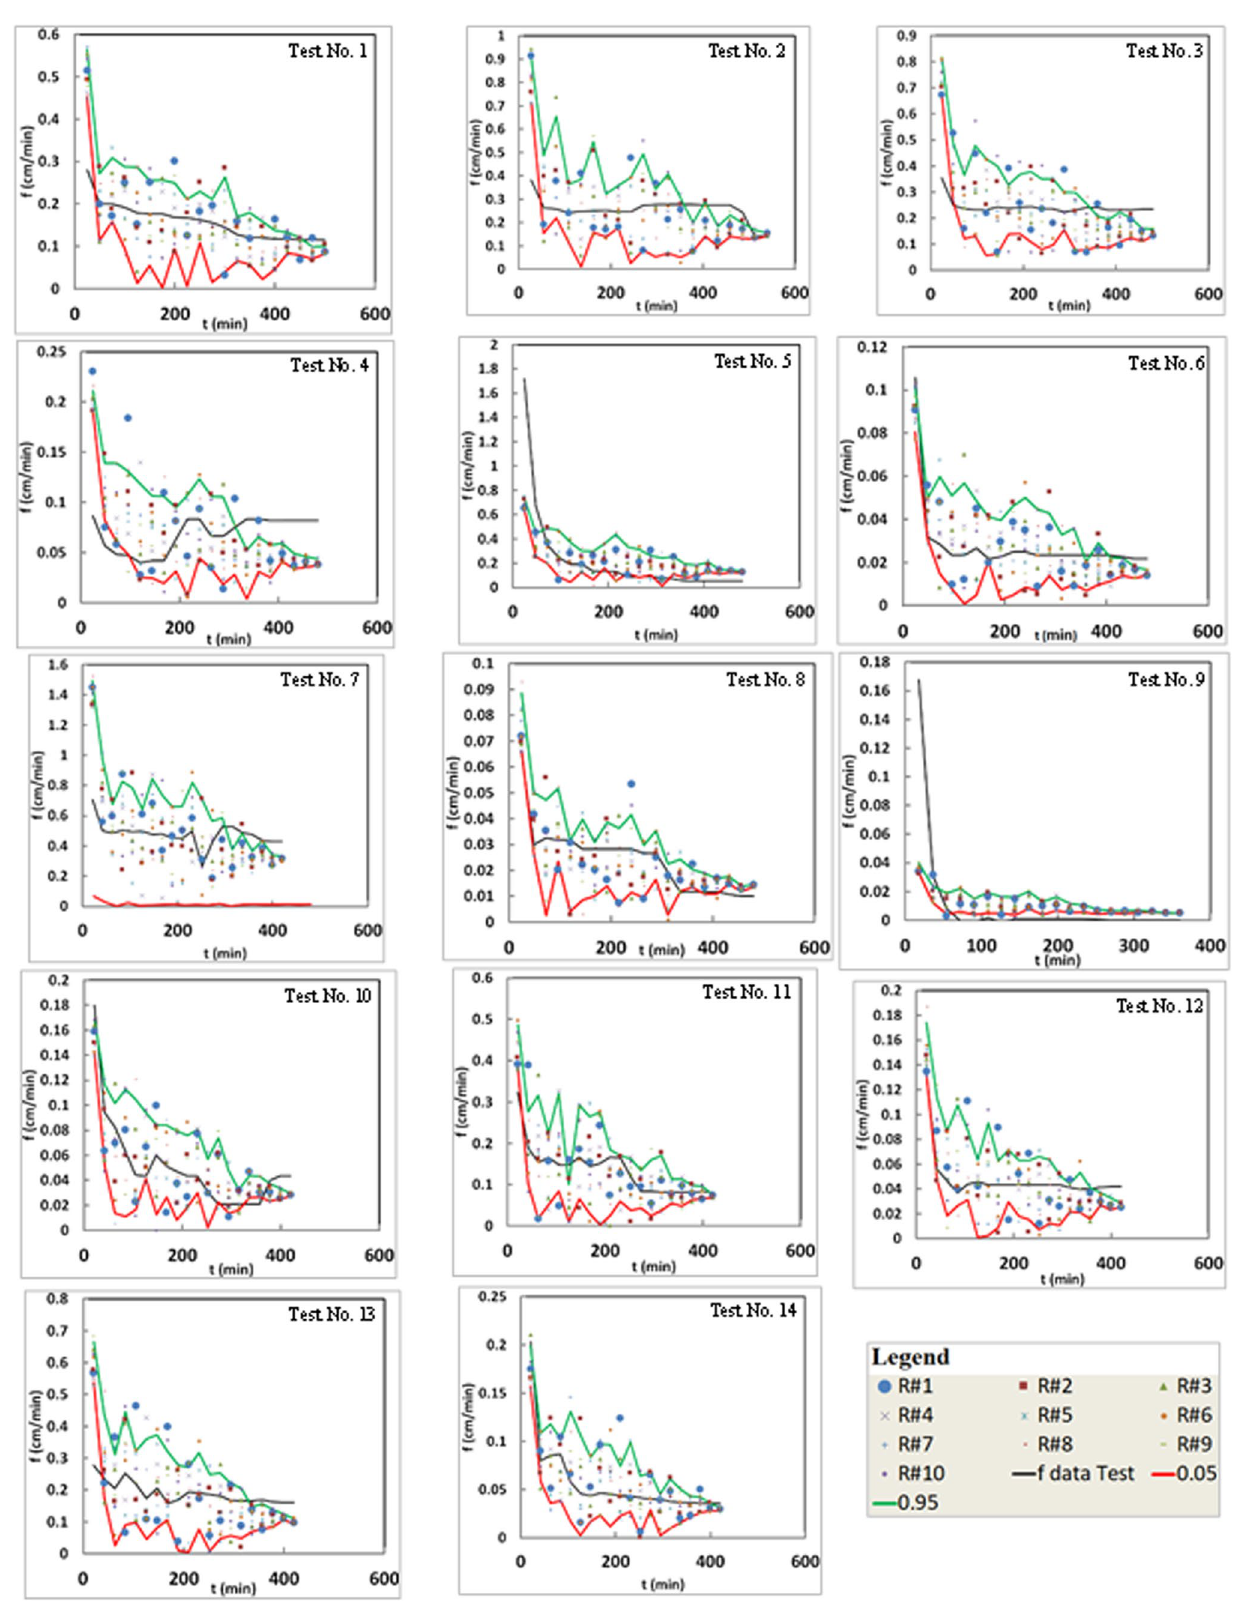
Fig. 12 Simulation results of the infiltration tests (infiltration rate, f vs. time, t ): The actual test (solid line), ten generated realizations (dots), and the upper (95% confidence) and lower (5% confidence)